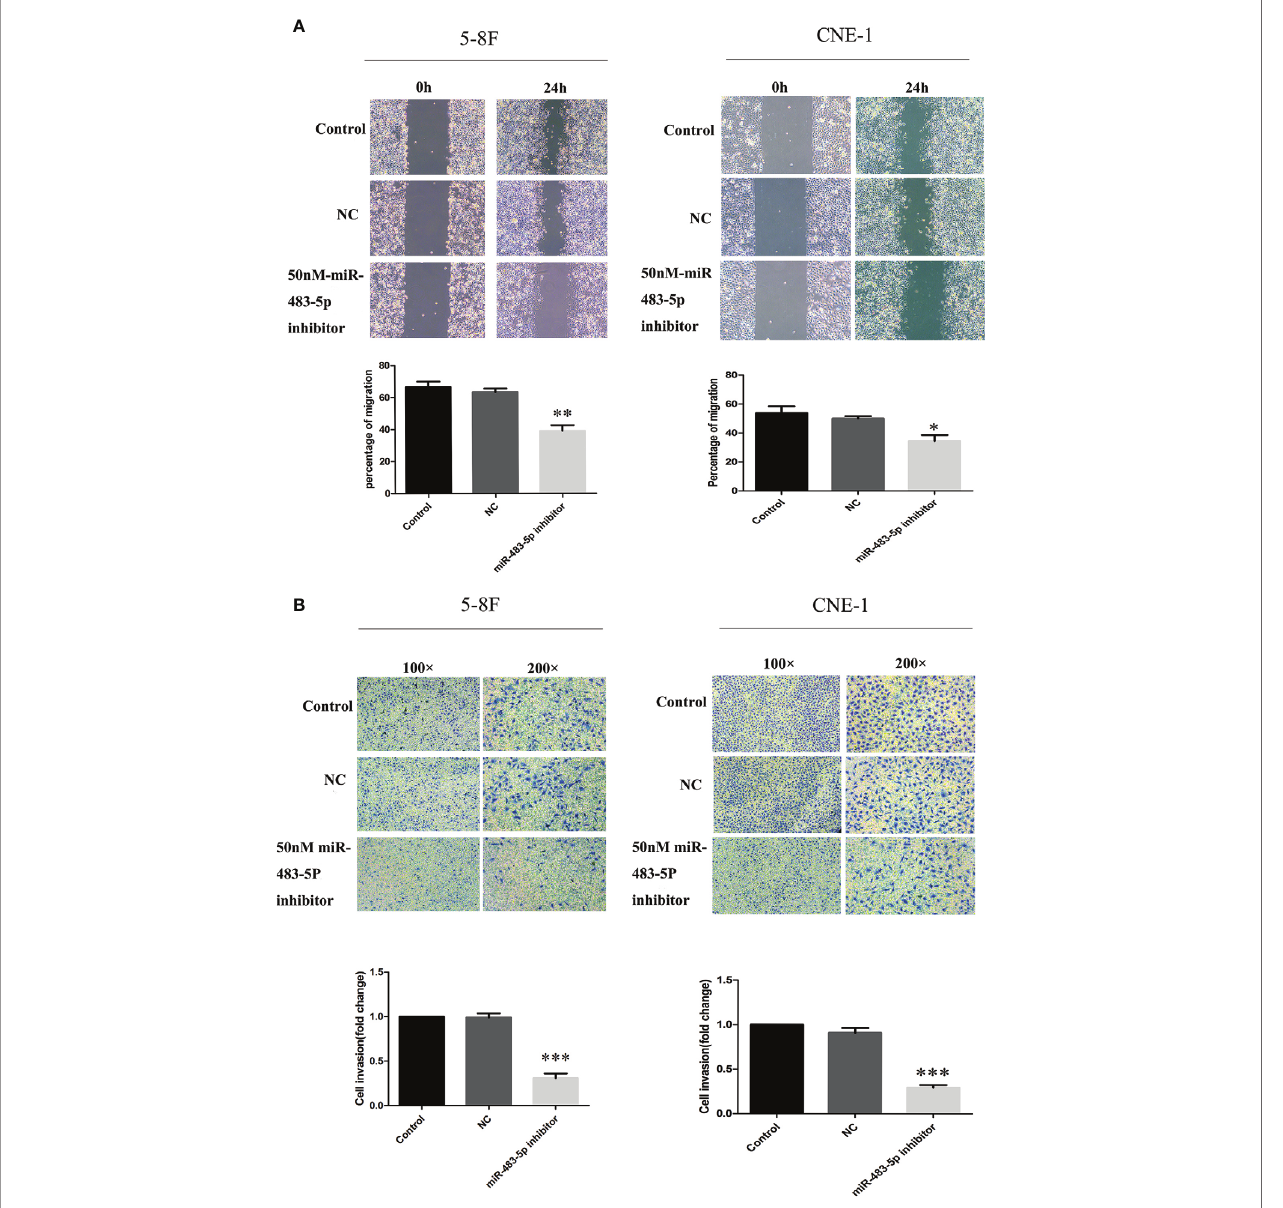
FIGURE 2 | MiR-483-5p promoted the migration and invasion of nasopharyngeal carcinoma (NPC) cells in vitro . (A) Cell migration ability measured by the scratch wound healing assay. (B) Cell invasion ability measured by Boyden chamber assays with Matrigel. * p < 0.05, ** p < 0.01, *** p <